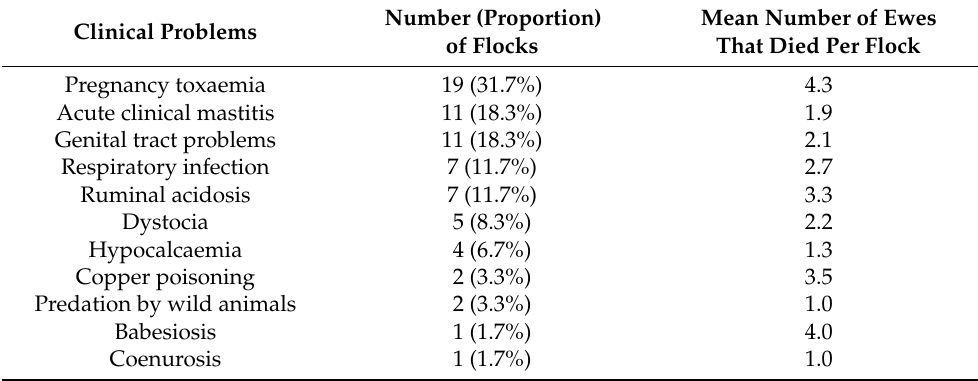
Table 3. Number of flocks in which the clinical problems associated with peri-parturient deaths 1 , were recorded during a two-year study in 60 sheep flocks in Greece.